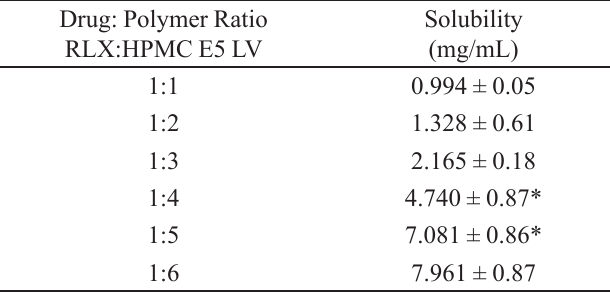
FIGURE 1 - Dissolution profiles of raloxifene HCl and solid dispersions prepared by microwave induced fusion methods.